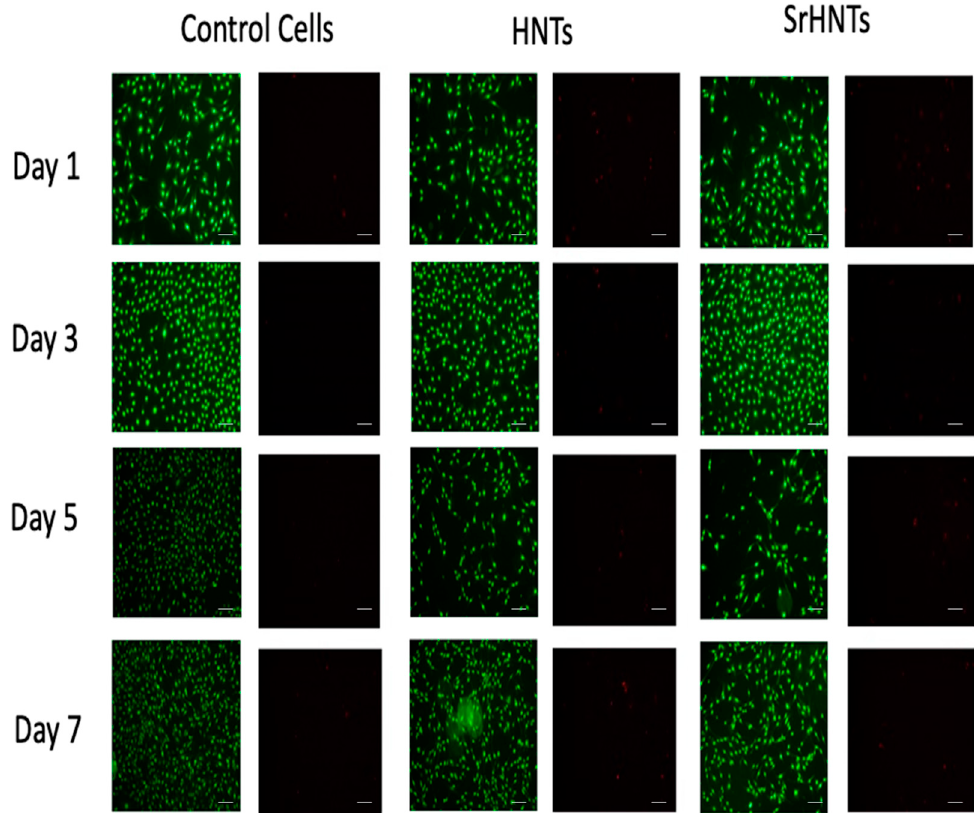
Figure 7. Live/Dead assay of two concentrations, 25 and 50 μ g/mL of HNT and SrHNT, showing live cells in green images and dead cells in red for days 1, 3, 5, and 7.